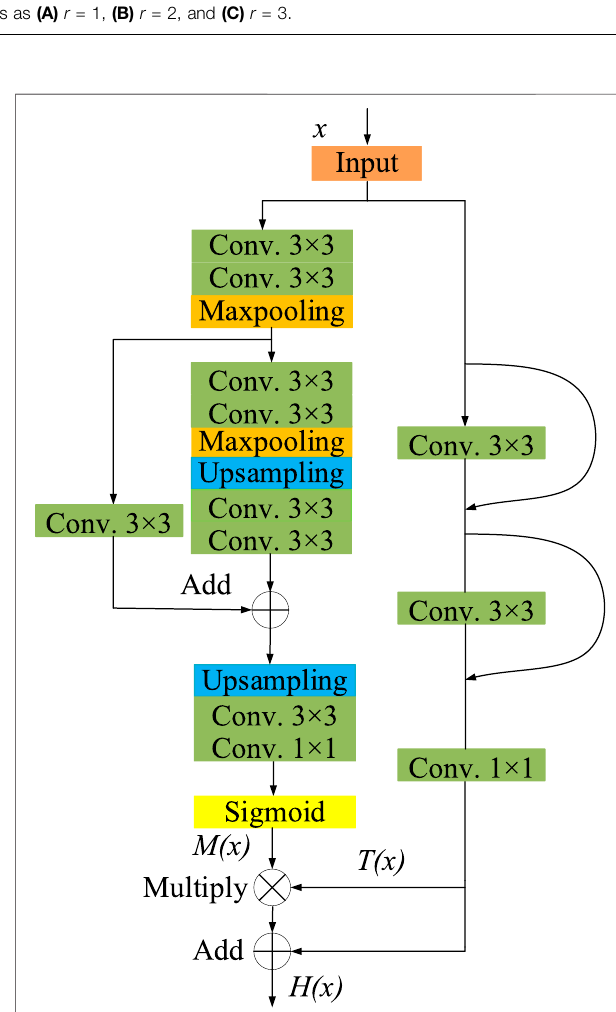
FIGURE 4 | The schematic diagram of residual attention